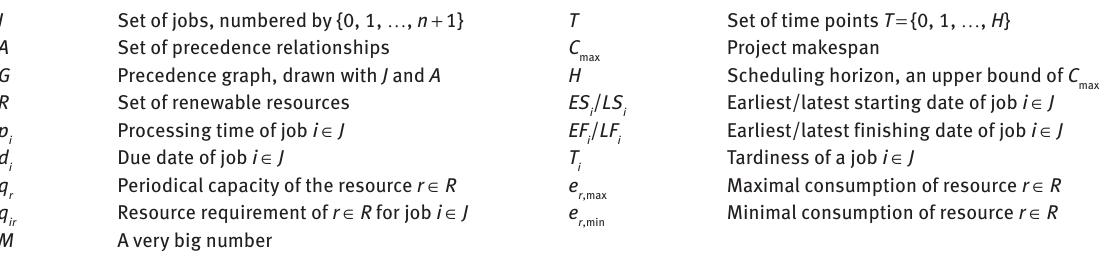
Table 1: Notations for the Mathematical Formulation.